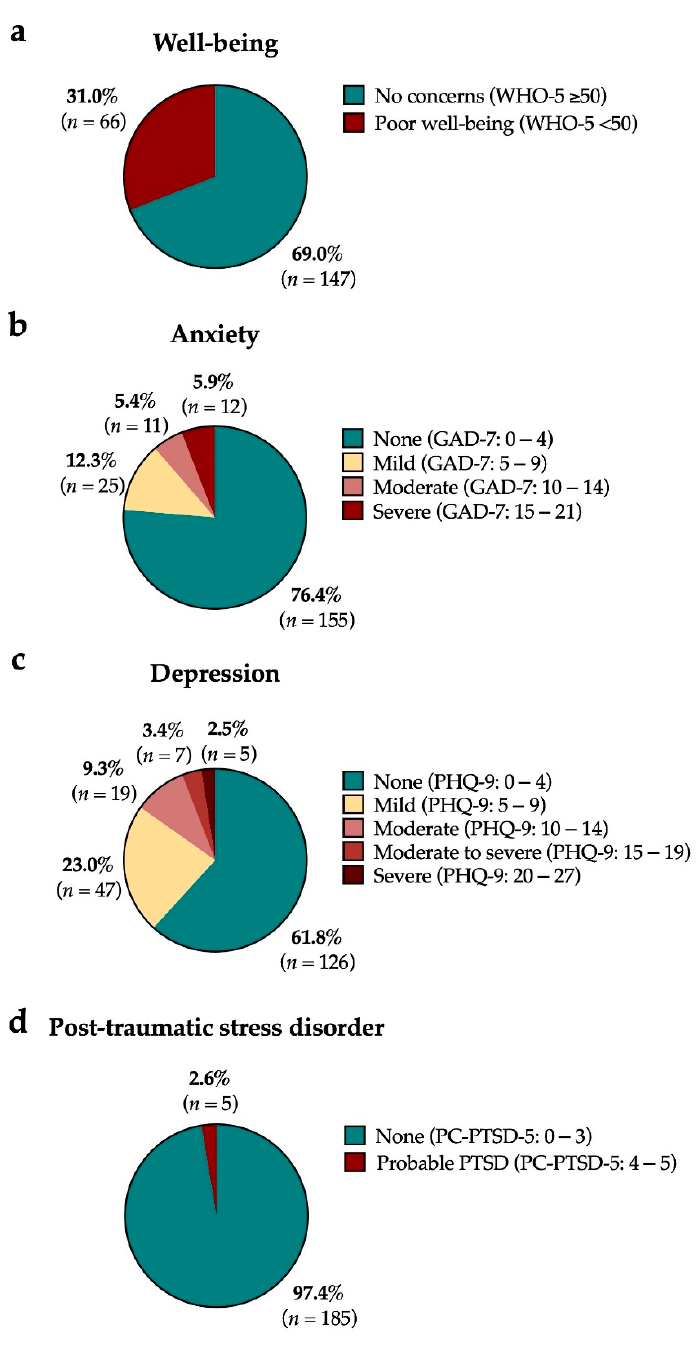
Figure 1. The impact of the COVID-19 pandemic on the levels of ( a ) poor well-being, ( b ) anxiety, ( c ) depression, and ( d ) post-traumatic stress disorder (PTSD) in patients with colorectal cancer ( n = 216). Abbreviations: GAD-7, Generalized Anxiety Disorder scale; PC-PTSD-5, Primary Care Post-Traumatic Stress Disorder-5; PHQ-9, Patient Health Questionnaire-9; WHO-5, World Health Organization Well-being